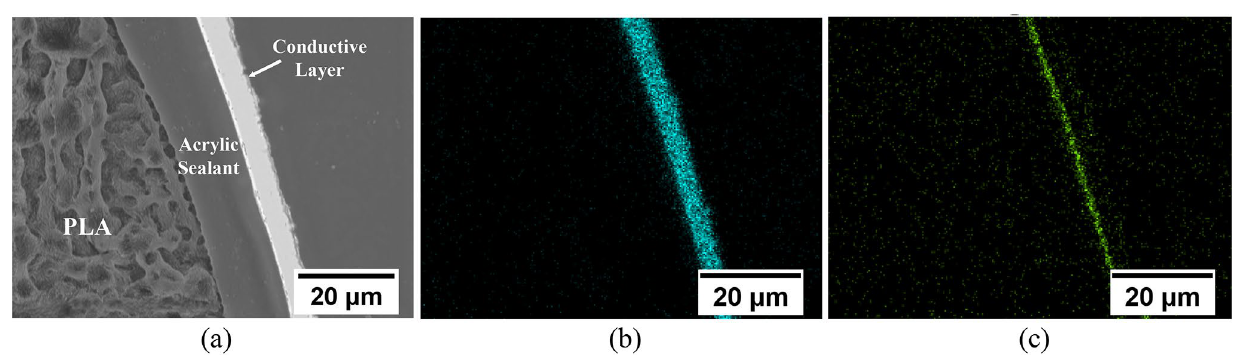
Figure. 8. (a) SEM micrographs of the FSS after the copper plating; (b) energy-dispersive X-ray spectroscopy (EDS) element maps for raw materials copper and (c) silver